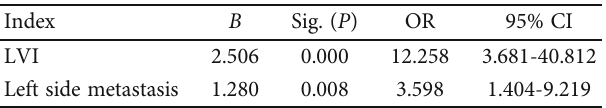
Table 5: Logistic analysis of risk factors for axillary lymph node metastasis.